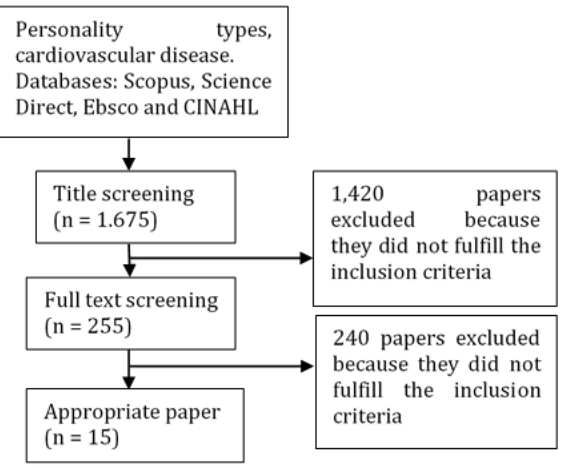
Figure 1. Flowchart of the research on personality type with cardiovascular